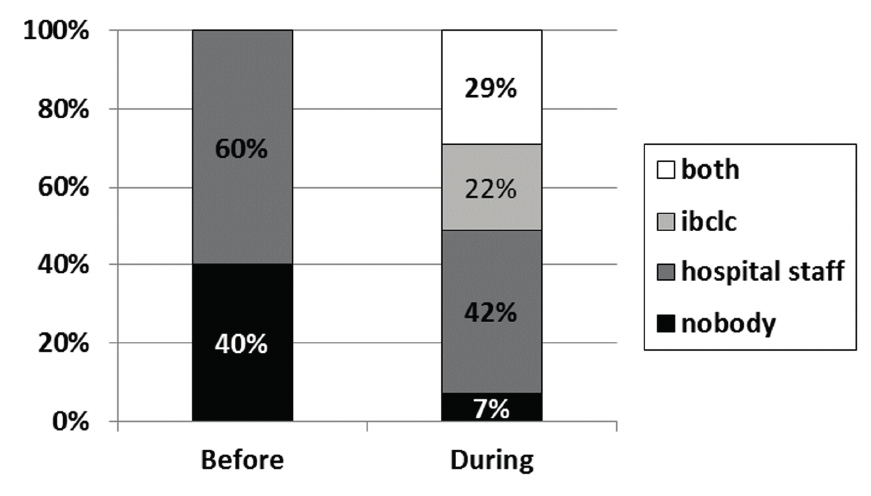
Figure 1. Percentage of women who received help with breastfeeding from hospital staff and or